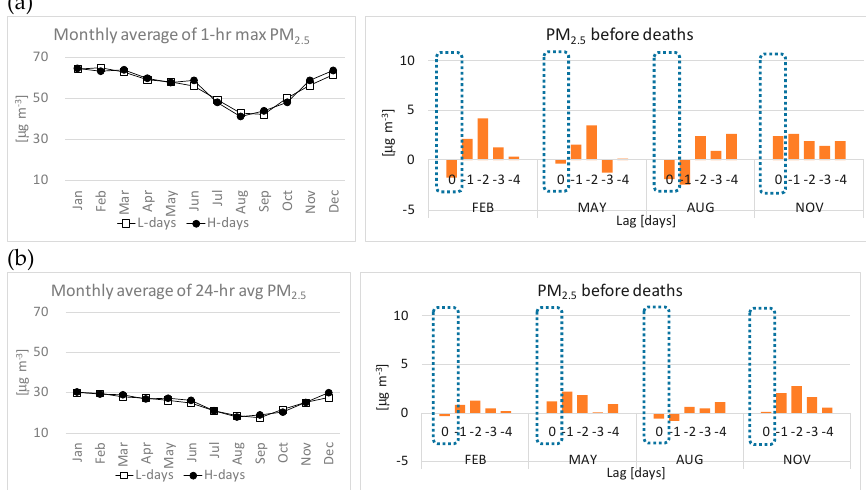
Figure 4. Concentrations of particles less than 2.5 μ m in size (PM 2.5 ) on days with a higher or lower probability of deaths from respiratory disease, and those from zero to 5 days before deaths in February, May, August, and November between 2008 and 2017: ( a ) 1-h maximum and ( b ) 24-hour average PM 2.5 concentrations. PM 10 concentrations were relatively higher in winter and in spring (Figure 5). The high PM 10 concentrations during relatively cold seasons are also related to the relatively low mixing height during the cold season, because pollutants can accumulate in the lower troposphere if the mixing height is low [34]. The period in which maximum PM 10 concentrations were observed was consistent with days with an inflow of yellow dust from the west of Korea [35]. Differences in PM 10 concentrations 1 day and 2 days before death were obvious in February, May, and November, which implied that PM 10 concentrations one or two days before death had a large impact.